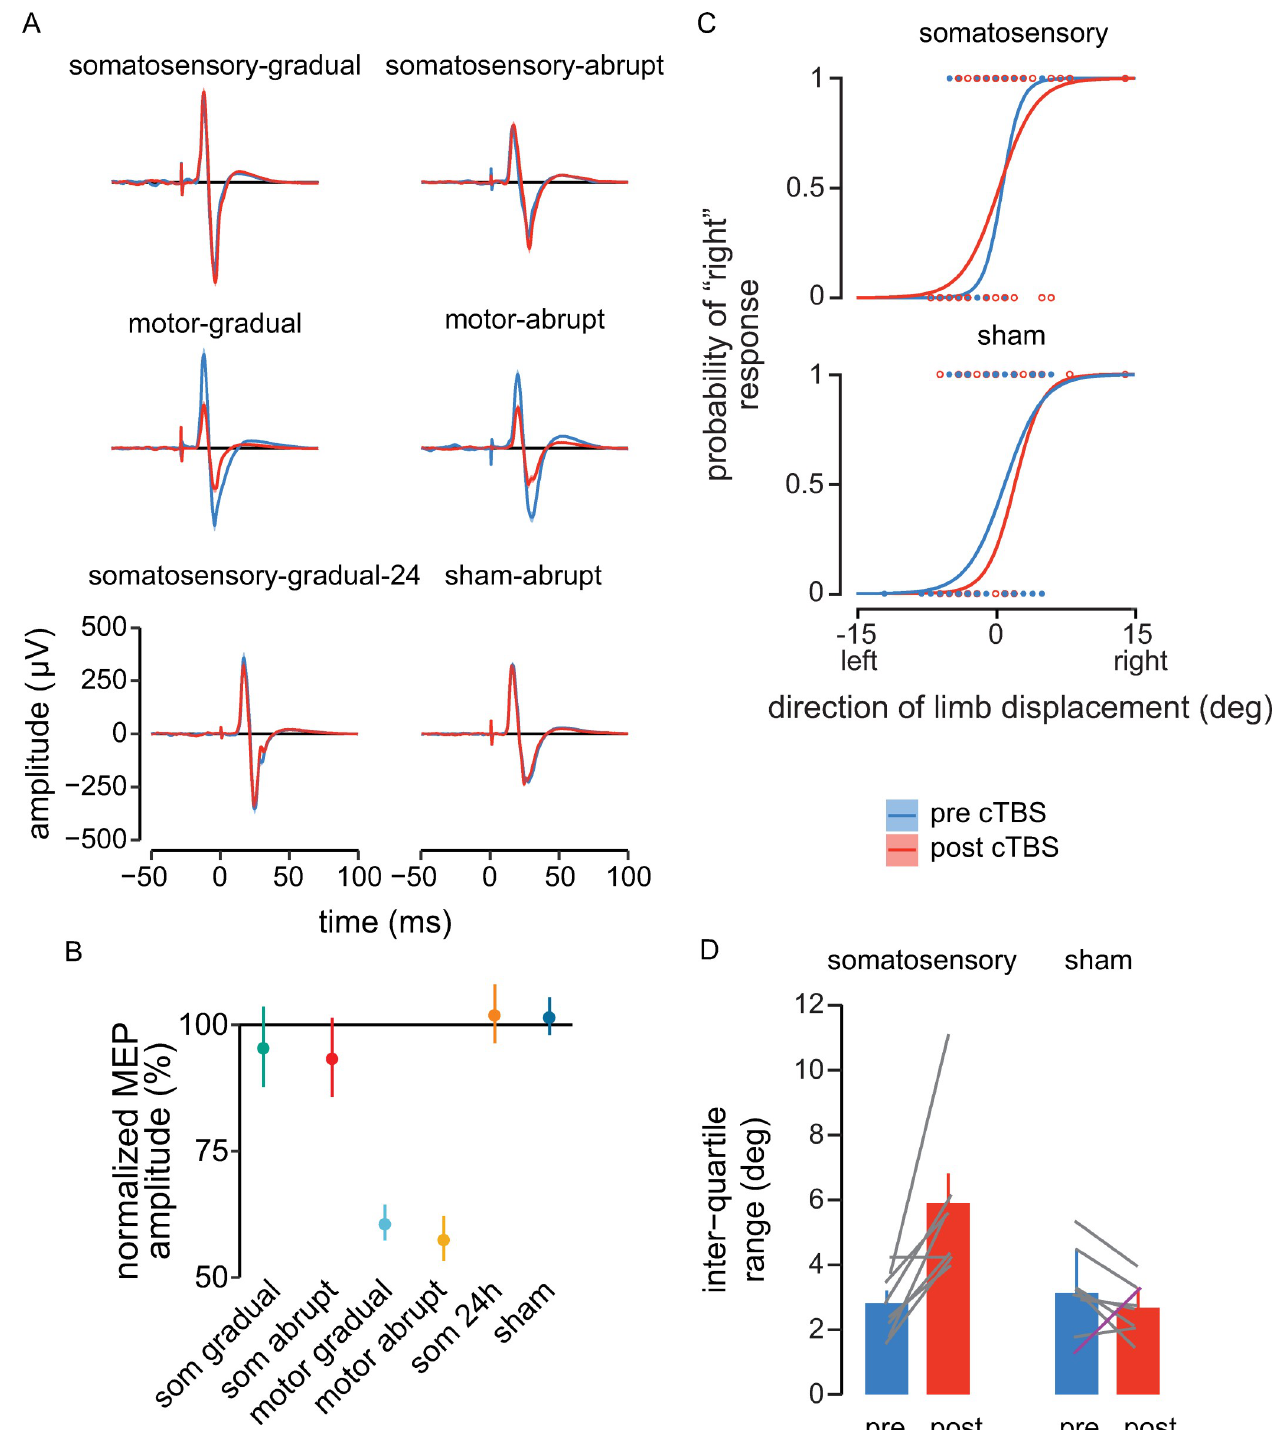
Fig 2. Excitability of motor cortex is not affected by cTBS over somatosensory (“som”) cortex, whereas cTBS over motor cortex suppresses its excitability. cTBS to somatosensory cortex decreases perceptual acuity. (A) Mean time series of MEPs recorded from biceps brachii pre- (blue) and post-cTBS (red) from a representative participant. The TMS pulse occurs at t = 0 ms. The shaded regions are ± SEM across 20 MEPs. (B) Mean change in amplitude of MEPs recorded post-cTBS (expressed as a percentage of pre-cTBS MEPs). Error bars give standard error across participants. (C) Psychometric fit to perceived limb position, showing performance of a representative participant before and after cTBS and sham stimulation. (D) Interquartile range pre- and post stimulation. Participants showed a decrease in perceptual acuity after suppression of somatosensory cortex. Error bars show standard error across